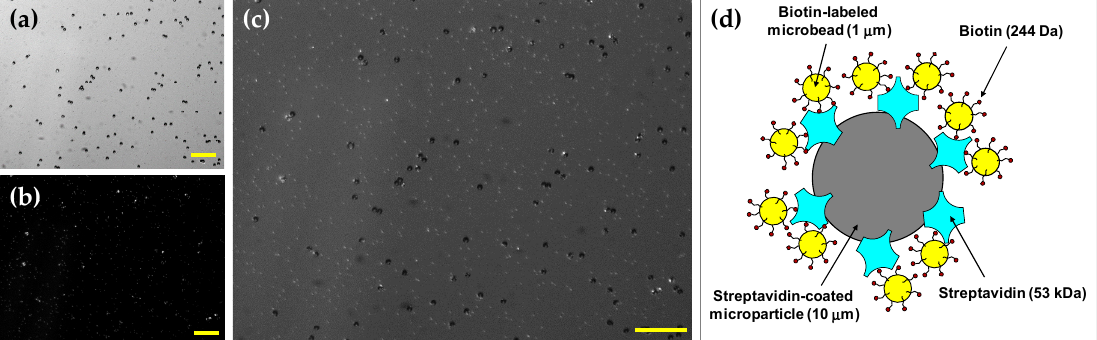
Figure 3. ( a ) Image of avidin-coated non-fluorescent polystyrene microparticles at the bright-field mode of the microscope. ( b ) Image of biotin-conjugated fluorescent microbeads under fluorescence illumination. ( c ) Image of avidin-biotin microbead complexes at both fluorescence and bright-field modes. (scale bar = 100 μ m) ( d ) Schematic diagram of the binding of biotin-labeled microbeads to a streptavidin-coated microparticle.